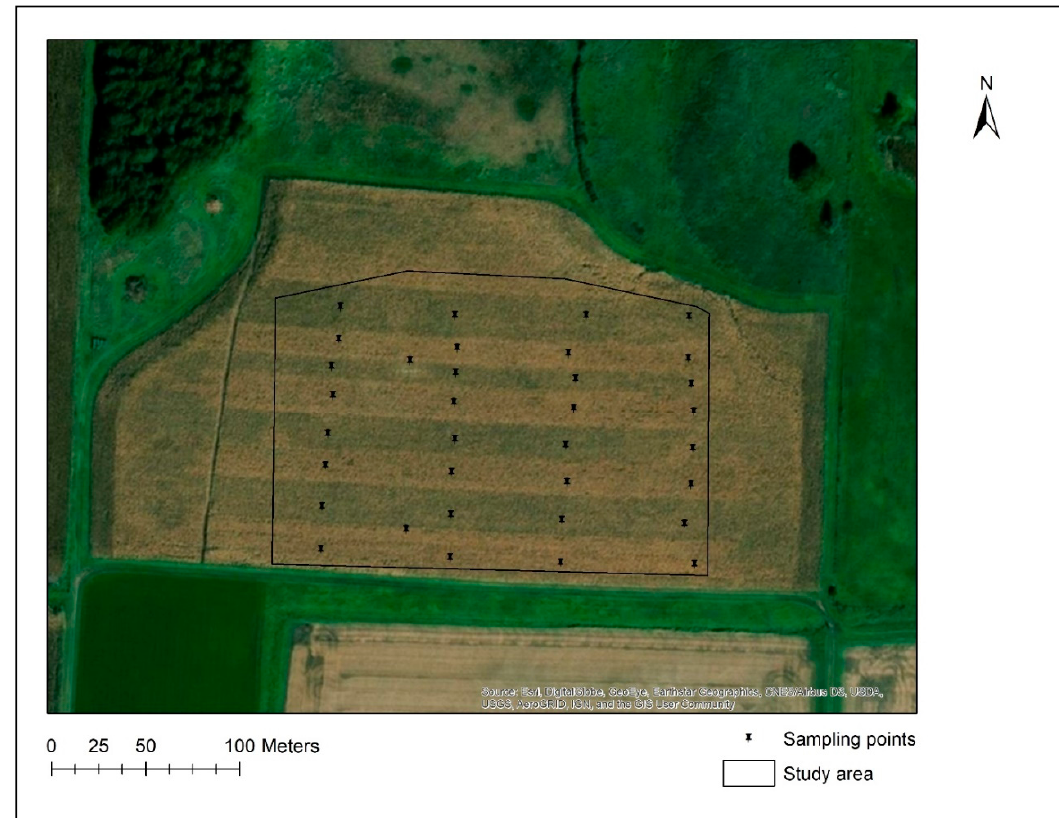
Figure 1. Map of the study site, which delineates the study area and shows soil and plant sampling points for the 2017 growing season.